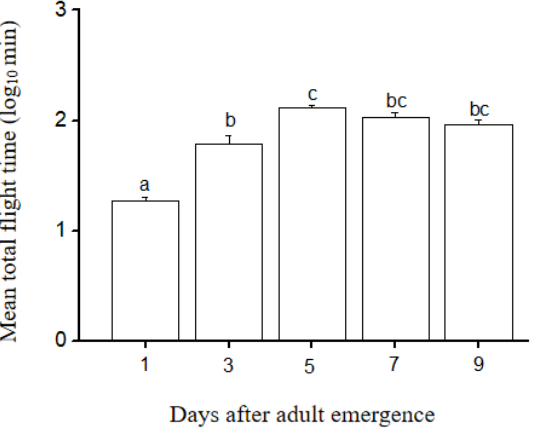
Figure 1. Effect of age on the mean total flight time of LW females of V. asperses stimulated to fly in a 4 h period. Different letters indicate a significant difference between groups by post hoc multiple comparisons of the means, p < 0.05, n = 40 for each